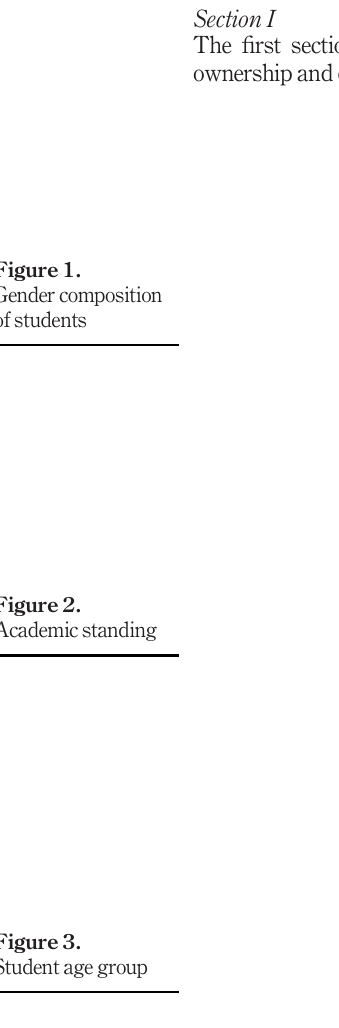
Figure 3. Student age